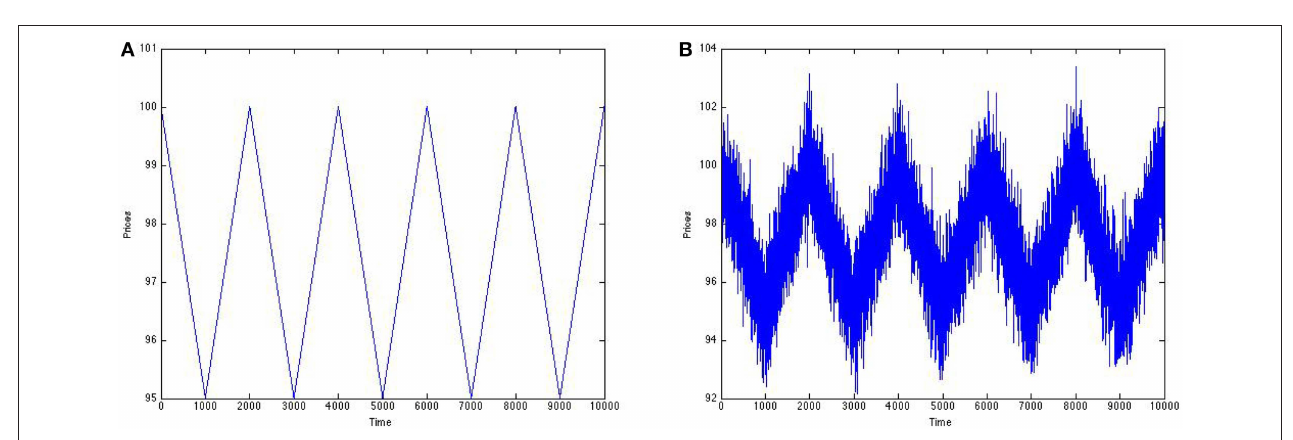
FIGURE 8 | (A) Prices. (B) Prices after noise from small scale